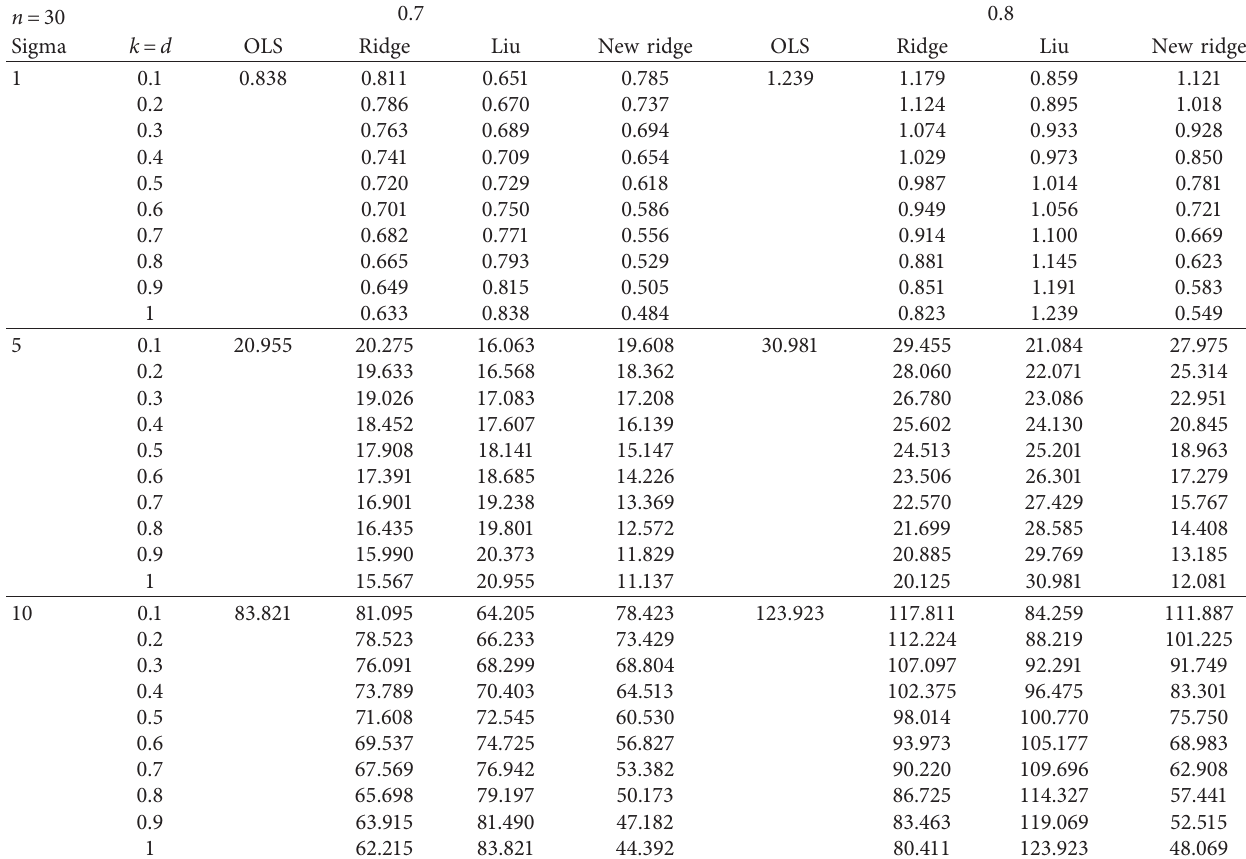
Table 5: Estimated MSE when n � 30, p � 7, and ρ � 0.70 and